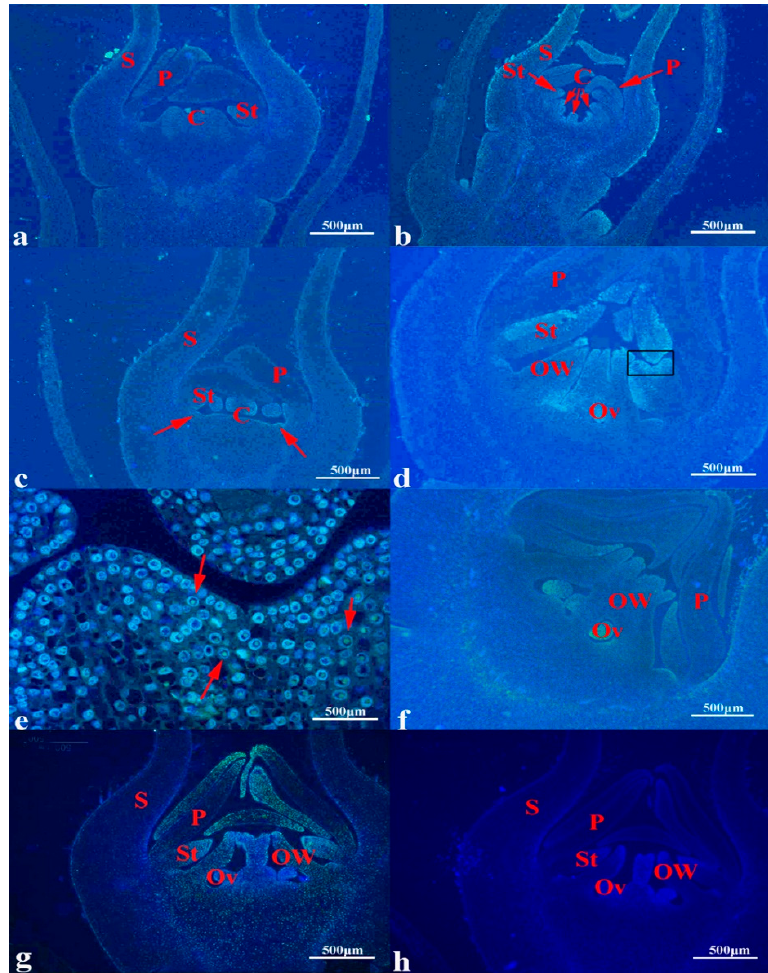
Figure 6. TUNEL staining of female floral buds during differentiation in persimmon. ( a , b ) The carpel primordium differentiation stage harvested on April 5, 2017 and April 8, 2017 showed that there was no observable DNA damage in the stamen primordium of female floral buds. ( c ) April 11, 2017 was defined as the ovule primordium differentiation stage, when the levels of dead cells in the stamen primordium equaled those of the carpel primordium differentiation stage (arrows indicate nectary tissues). ( d ) Strong positive staining for dead cells of the stamen primordium based on green color was clearly observed at the internal and external integument and macrosporocyte stage harvested on April 14, 2017. ( e ) Image of the stamen from the rectangle magnified in ( d ) (arrows indicate dead cells). ( f ) The dead cells of the stamen primordium in tissues harvested on April 17, 2017 were almost invisible. ( g ) Positive control for the female flower bud harvested on April 14, 2017 showing nuclei evenly stained in the stamen primordium after DNase treatment prior to the TUNEL assay. ( h ) Negative control for the female flower bud harvested on April 14, 2017, where no TUNEL signals were observed in the stamen primordium. (C = carpel; Ov = ovule; OW = ovary wall; P = petal; S = sepal; St = stamen).